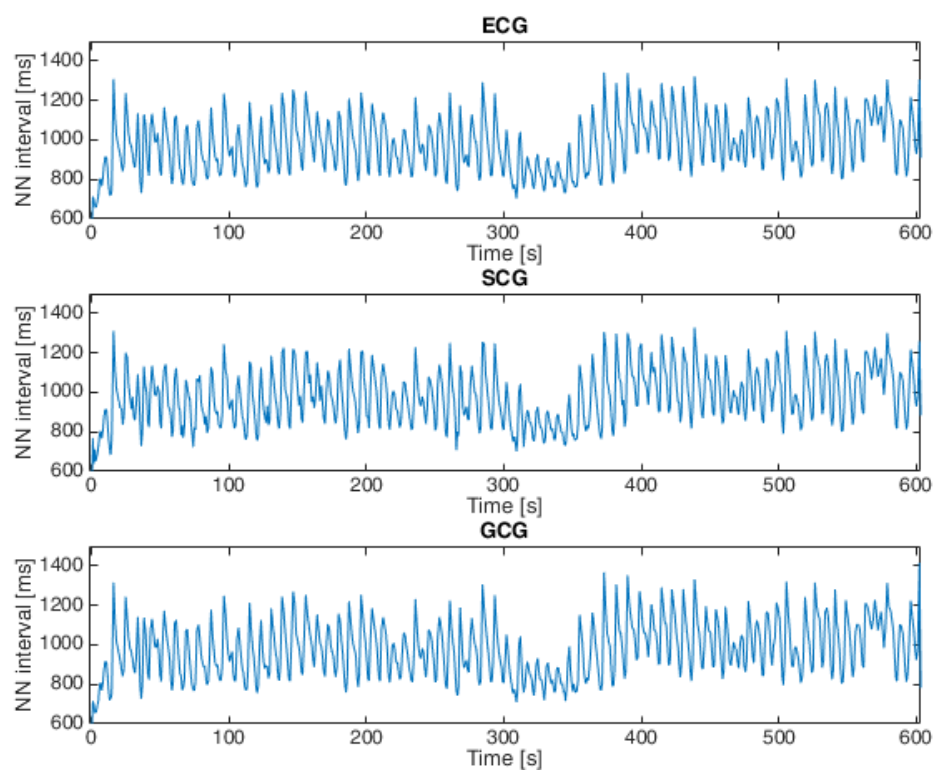
Figure 4. Tachogram derived from ECG, SCG and GCG signals taken from subject 9 in the first dataset (15-second fragment).